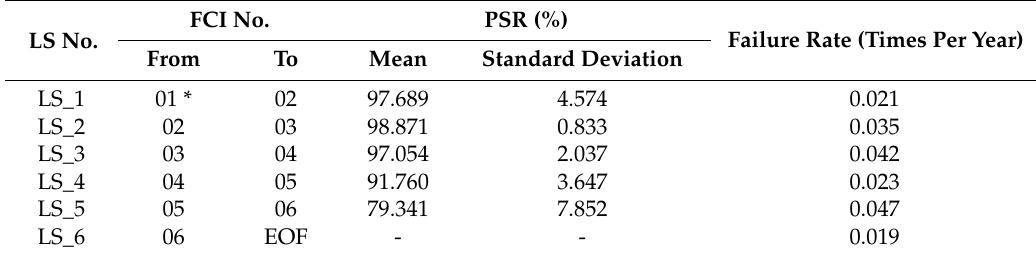
Table 4. PSR and failure rate of each line